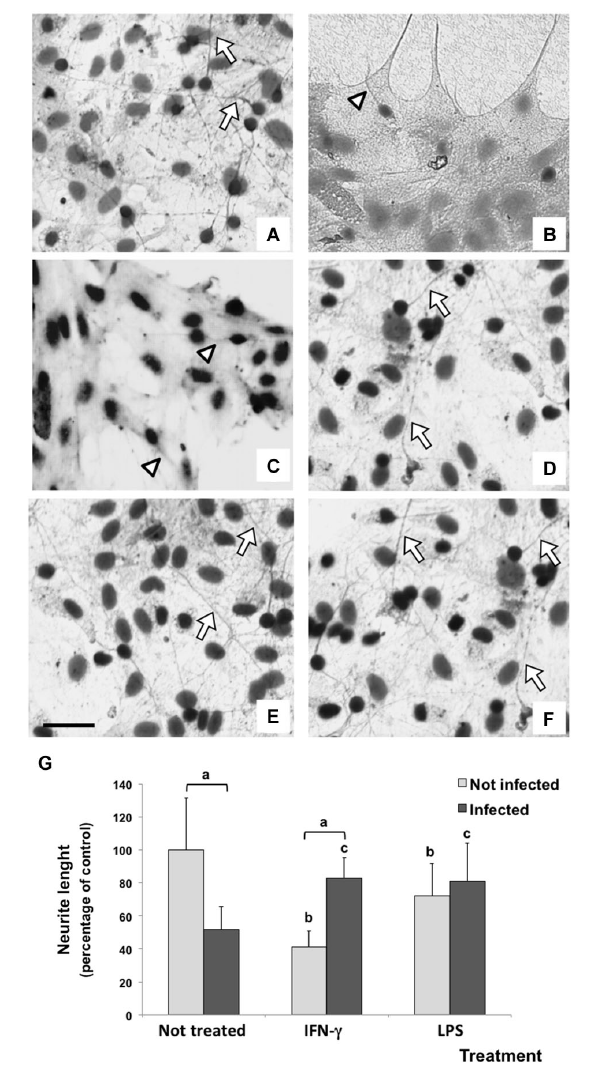
FIGURE 5 | Immunodetection (immunoperoxidase) of tubulin β III of rat neuron/glial cells co-culture treated with 300 IU/mL of IFN- γ and 1 mg/mL of LPS and infected with Neospora caninum tachyzoites (ratio cell:parasite 1:1), 72 h post infection . Control cells maintained in fresh medium exhibit a basal neurite outgrowth (arrow) (A) ; a drastic impairment of neurite (arrowhead) was observed in N. caninum infected culture (B) and IFN- γ treated cells (C) ; neurite length (arrow) in IFN- γ /infected cultures (D) ; LPS/uninfected and LPS/infected cells did not exhibit changes in neurite lenght (E,F) . Scale bar = 50 µ m. (G) Measurement and statistical analysis of neurite length (percentage of control) and its respective standard deviation compared to untreated/uninfected cultures (considered as 100%) in three samples in three independent experiments. “a” represents a significant statistical difference between the same treatment group; “b” represents a significant statistical difference when compared to untreated/uninfected control cultures; “c” represents a significant statistical difference when compared to untreated/infected cultures (Two-way ANOVA/Tukey’s Multiple Comparison Test— p < 0.05).